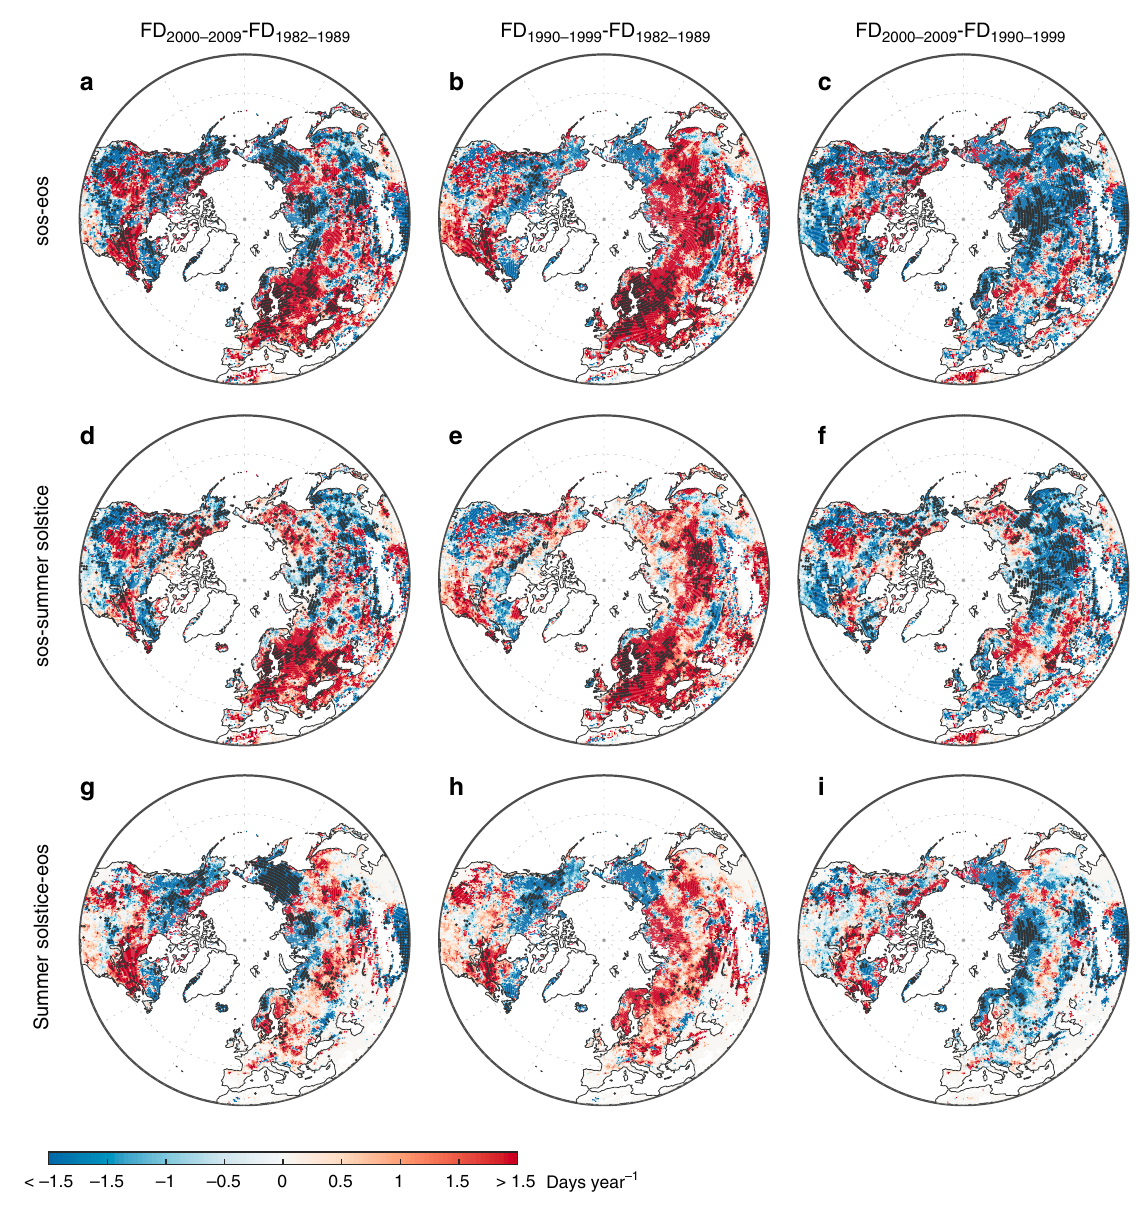
Fig. 2 Decadal changes in average frost days during growing season. The number of frost days (FD) in the Northern Hemisphere was averaged from the results of the Princeton and WFDEI data sets. The left, center, and right panels indicate the differences in the average number of frost days between the 1980s and the 2000s, the 1980s and the 1990s, and the 1990s and the 2000s. The upper, middle, and bottom panels show the time periods used to calculate the number of frost days ( a – c GSFDs, from SOS to EOS, d – f SPR-FDs, from SOS to the summer solstice, and g – i FAL-FDs, from the summer solstice to EOS). Dotted areas indicate regions with signi fi cant changes ( P < 0.05, t -test) in the number of frost days. Maps were created using